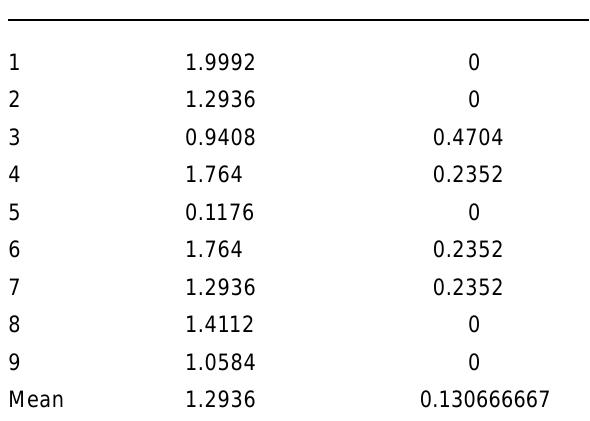
TABLE 1- Apex-to-filling distance (mm) and leakage extent (mm) in the non-disrupted (ND)